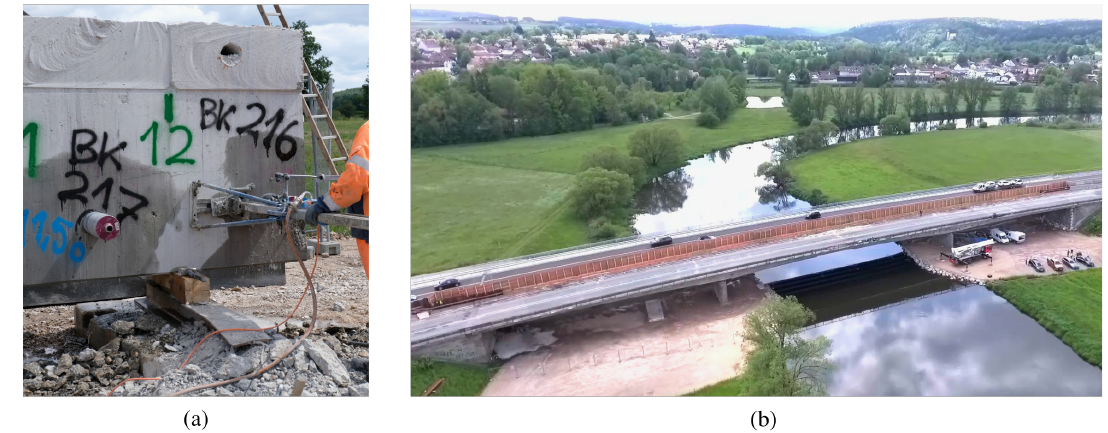
Figure 1. (a) Sampling of the drilling cores and (b) bird’s eye view of the investigated bridge in Roding.